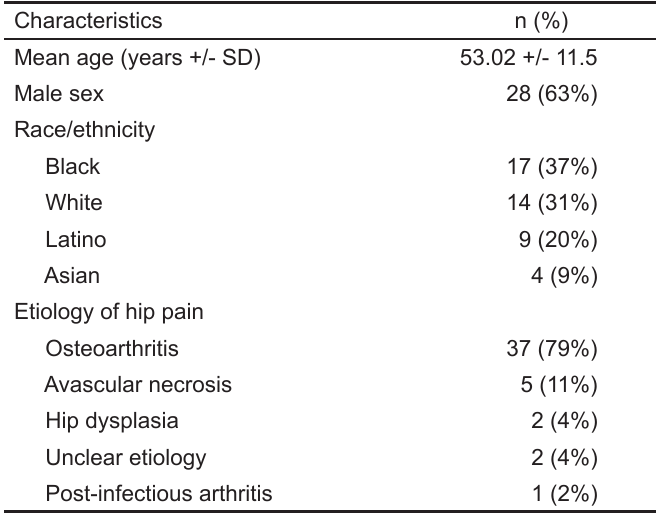
Table 1 . Demographic features of 44 patients enrolled